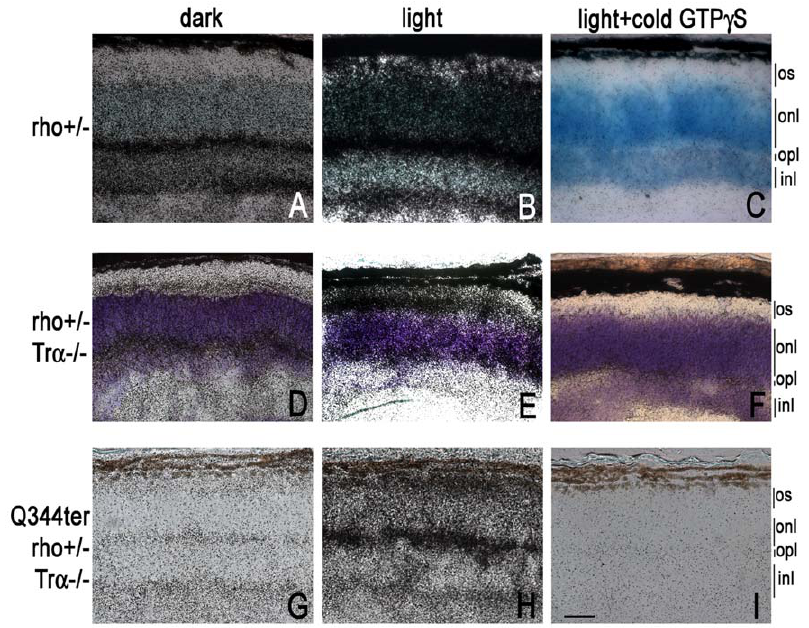
Figure 7. Light-dependent GTP c S loading (20 min exposure) in transgenic Q344ter frozen retinal sections. [ 35 S]GTP c S binding in situ was performed on unfixed frozen retinal sections from mice with the indicated genetic backgrounds. Basal [ 35 S]GTP c S loading in the dark labels the synaptic layers ( A, D, E ), while light-exposure lead to additional labeling at the inner and outer segment compartments ( B, E, H ). Panels C , F, and I show non-specific background labeling. Scale bar =20 m m. All panels are taken at same magnification.